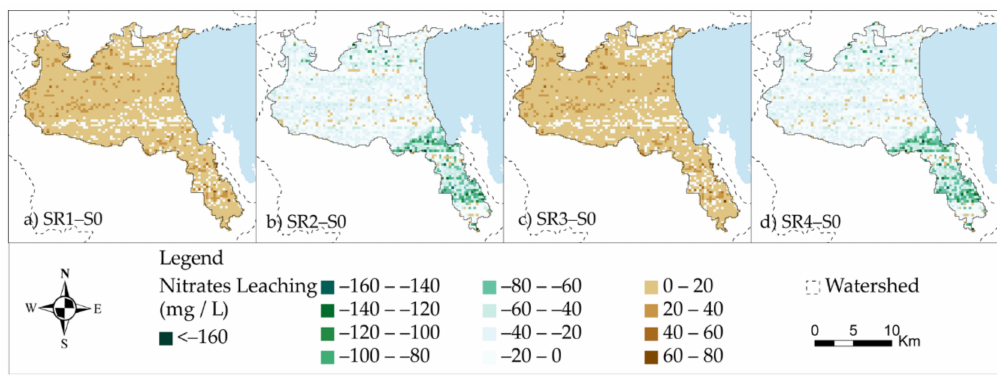
Figure 7. Spatial differences of averaged nitrates leached between the baseline scenario (S0) and the agronomic and water resources management scenarios of the simulation period 1991 to 2018.